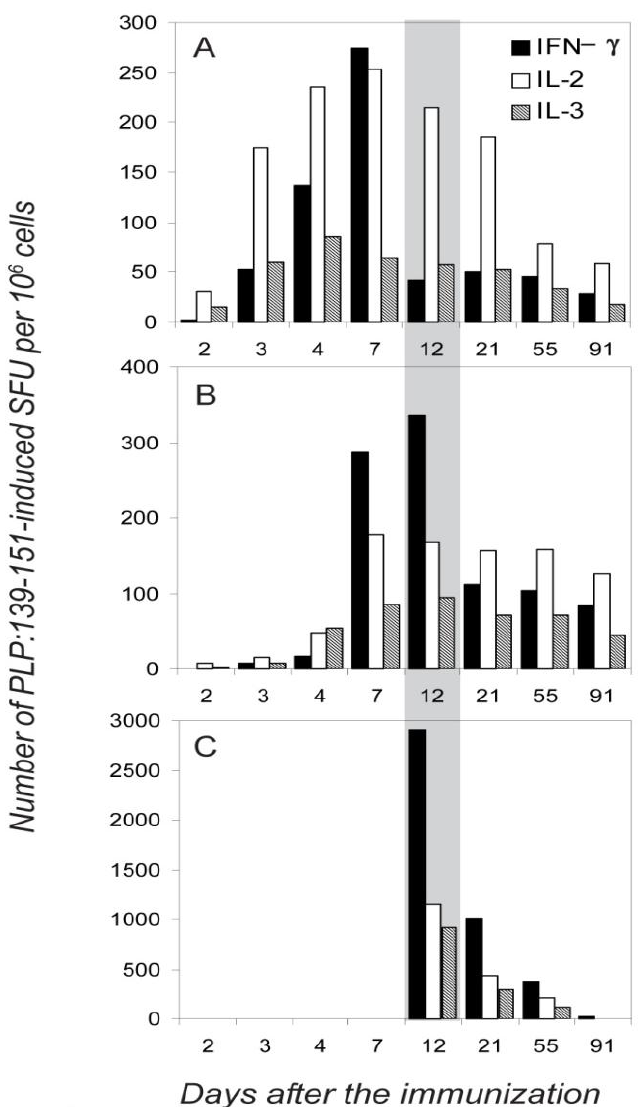
Figure 5. Different organ distribution of PLP:139-151-specific single-cytokine producing T cells during the course of EAE. The frequencies of PLP:139-151-induced IFN- (cid:534)(cid:15)(cid:3)(cid:44)(cid:47) -2 and IL-3 spots are shown per one million of mononuclear cells in the dLN (A), spleen (B) and spinal cord (C) measured at different time points after the immunization: days 2, 3, 4 and 7 (before the onset of EAE,) at day 12 (during the first paralysis), and at days 21, 55, and 91 (during the first, second and third relapses of paralytic EAE). The data shown are for T cell activation with 20 (cid:80) M PLP:139-151. Because the frequencies of double positive cells were consistently <7%, they are not included in the figure. In each experiment mean spot numbers were calculated from three (cid:177) four replicate wells, SD between replicate wells for all data points did not exceed 10%. For each time point, mean values are shown for data obtained in three independent experiments, testing four mice individually in each experiment. SD between the experiments was <15%. Because statistical analysis included intra- and inter- experiment data and because experimental errors were much lower then differences between data points we aimed to highlight, error bars are not